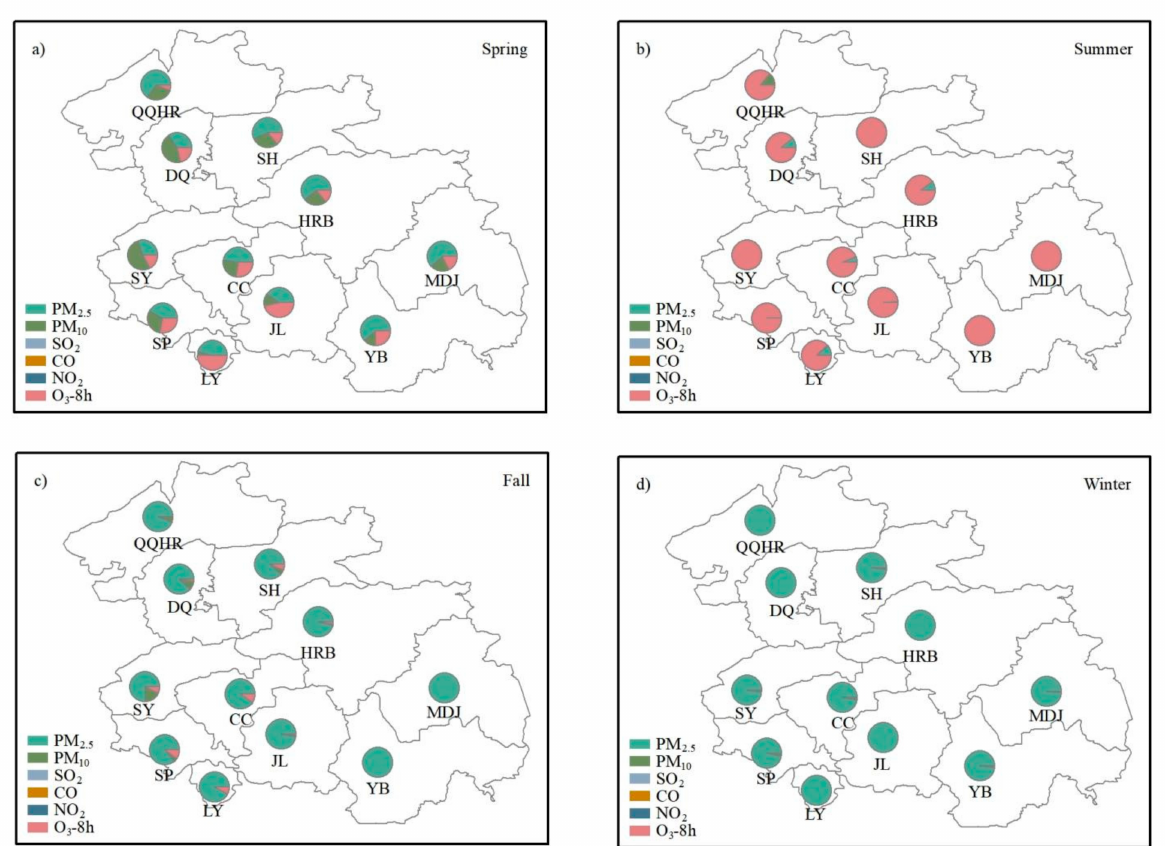
Figure 3. The proportion of the major pollutants in ( a ) Spring, ( b ) Summer, ( c ) Fall, and ( d ) Winter during non-attainment periods in the 11 cities of